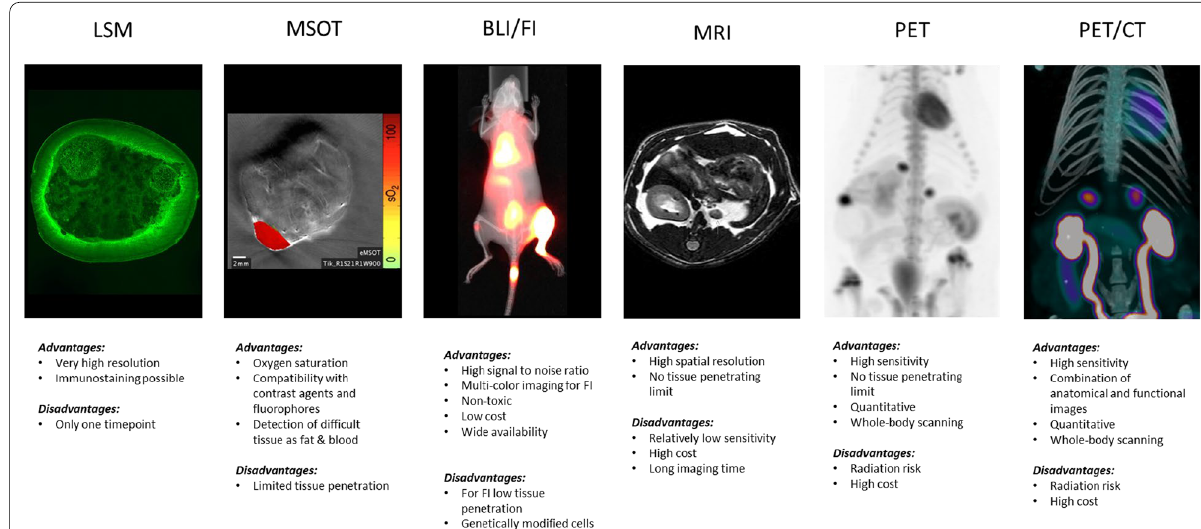
Fig. 2 Image modalities used for PPGL research in small animals. LSM Light sheet microscopy (PCC from a mut/mut MENX rat), MSOT multispectral optoacoustic tomography (MENX PCC senograft), BLI / FI bioluminescence/fluorescence imaging (metastasized MPC-luc cells in an allograft model, kindly provided by Martin Ullrich), PET positron emission tomography (MENX rat with [ 18 F]-LMI1195), PET / CT combined picture of PET and computed tomography (MENX rat with [ 18 F]-LMI1195 and CT). Advantages and disadvantage of each modality are